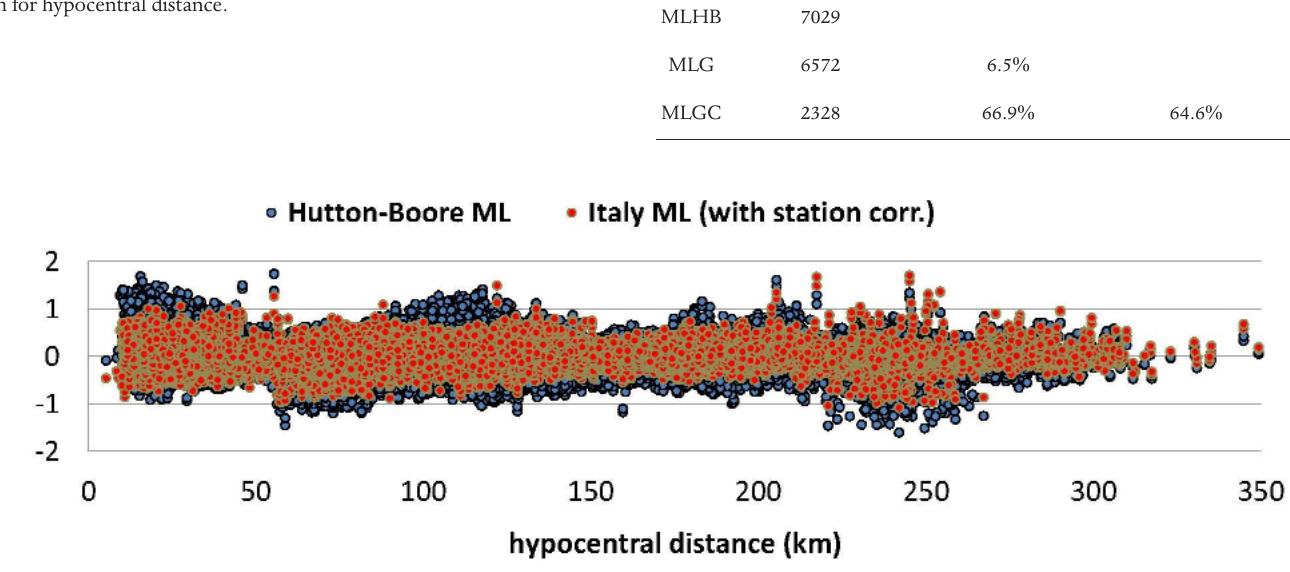
Figure A1. Map of the station corrections for the Emilia sequence. Greenish and blue circles, positive corrections (stations with amplitudes lower than the average); orange-red circles, negative corrections, seen for stations with local amplification or connected to the hypocenters of the sequence by paths crossing low attenuation areas. The negative corrections in stations where the Wood-Anderson amplitudes are, on average, larger than what would be expected applying the simple attenuation law by Gasperini, which is maybe caused by lower attenuation or local amplification and which is prevalent in the northern Italy and north-eastern Alps. The positive corrections are mainly in the northern Apennines and central Italy. The correspondence of this map with the web-based macroseismic intensity map of the main earthquake is strong (INGV, www.haisentitoilterremoto.it). It is worth noting that the magnitude station corrections we have found, should be applied to the Emilia sequence only, or to events with a similar location: the collection of a more general set of data belonging to earthquakes distributed all over the country is a preliminary condition necessary to compute the magnitude station cor- rections suitable for the entire Italian peninsula. Table A2 (right). Variance reductions for the 1574 events of the Emilia Variance seismic sequence (May-June 2012) obtained with the attenuation relation by Gasperini [2002] and with the Gasperini relation, plus station correc- tions (this study). The AIDA system today uses the Hutton-Boore correc- tion for hypocentral